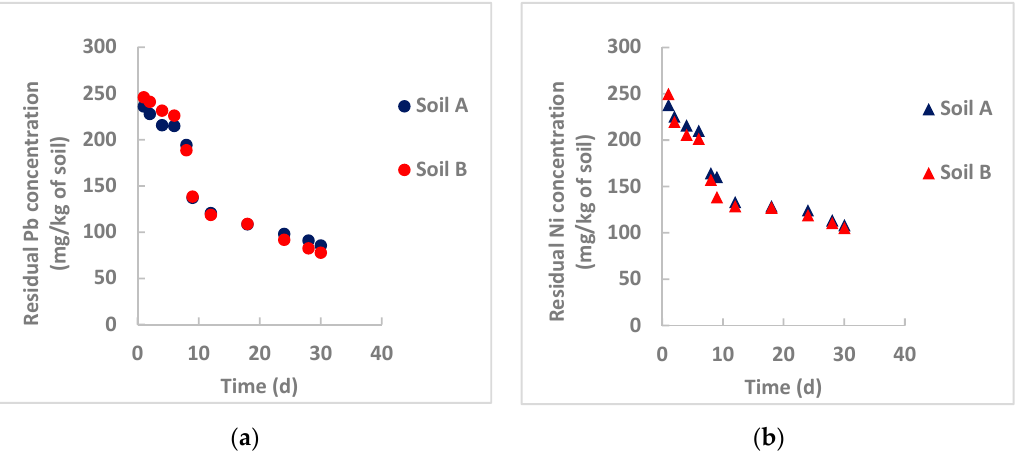
Figure 7. Remediation of nZVI particles synthesized using mint leaves (dosage: 0.2 g/kg of soil): ( a ) lead removal; ( b ) nickel removal.